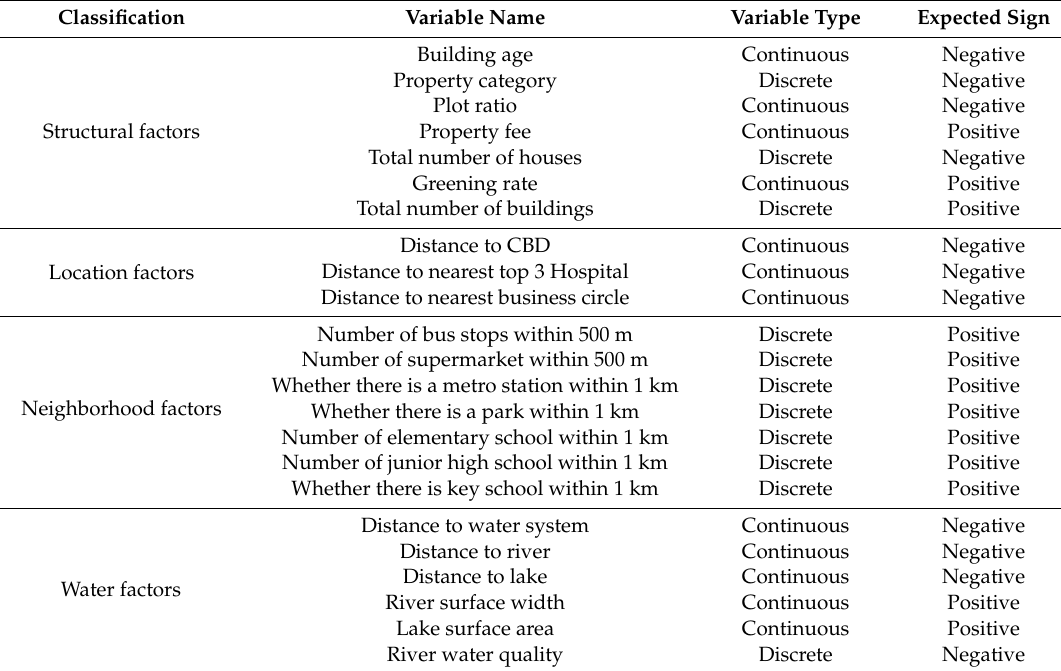
Table 1. Variable definition and